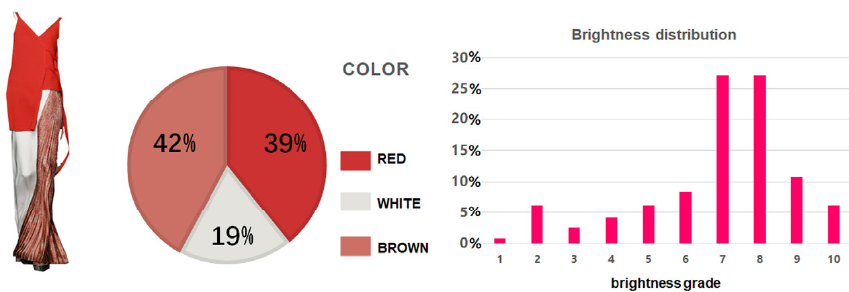
Figure 1. Conventional method of color data collection, analysis, and representation [8].